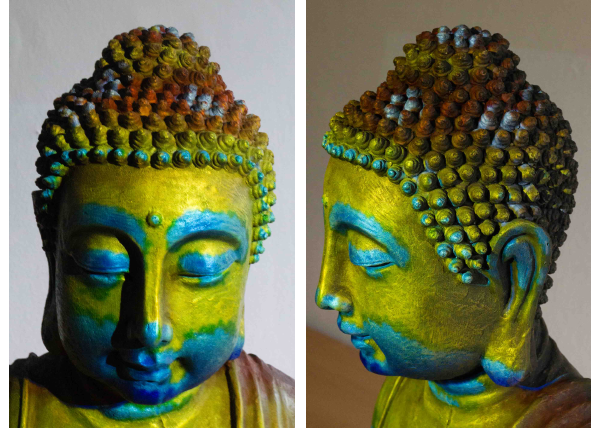
Figure 8. Detailed view of the projected color-coded representa- tion of a 3D comparison between the model of the statue and a point cloud. The detailed structures of the head allow to evaluate the quality of the